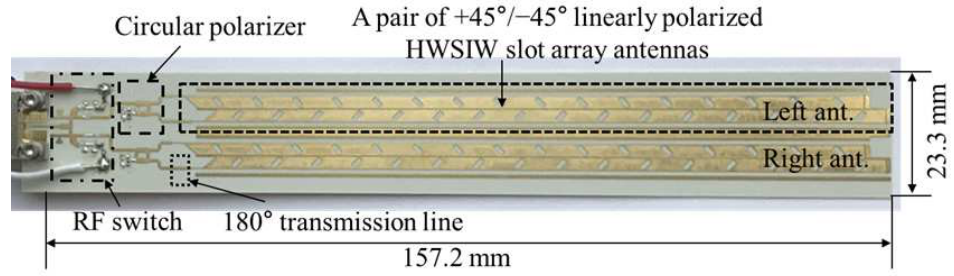
Figure 13. Picture of the fabricated beamwidth-reconfigurable HMSIW RHCP slot array antenna. Table 2. Operation modes of the beamwidth-reconfigurable antenna. Left Antenna Right Antenna